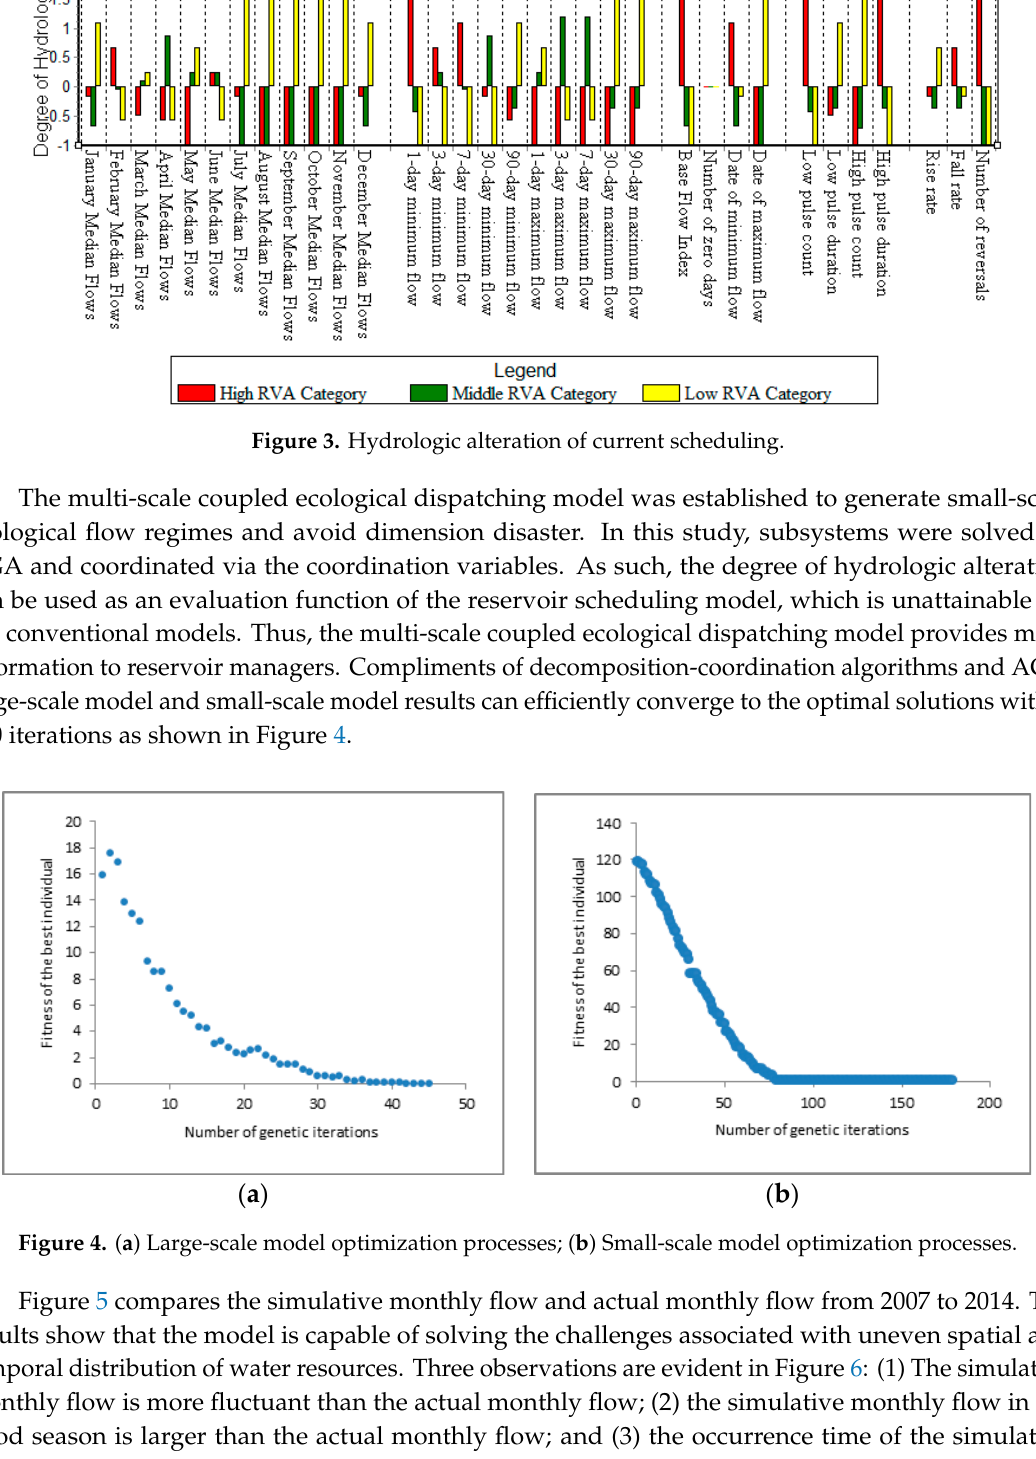
Figure 5. Monthly discharge from Xiaolangdi reservoir. The ‘percent-of-flow’ (POF) approach has been widely used in the USA, the European Union, and elsewhere over the past decade [3]. To contrast the above results, the flow was also generated using the POF approach, which sets protection standards by using allowable departures from natural conditions, expressed as percentage alteration. The hydrologic alteration of flow was calculated under the POF approach (Figure 6) and contrasted with the hydrologic alteration of simulative flow (Figure 6). Comparison of Figures 3 and 6 shows that the POF approach is more protective with respect to the magnitude of monthly water conditions—as the Hydrologic alteration of the magnitude of monthly water conditions were reduced from 81% to 65%. Yet, in other groups, particularly in the magnitude and duration of annual extreme conditions, the POF approach does